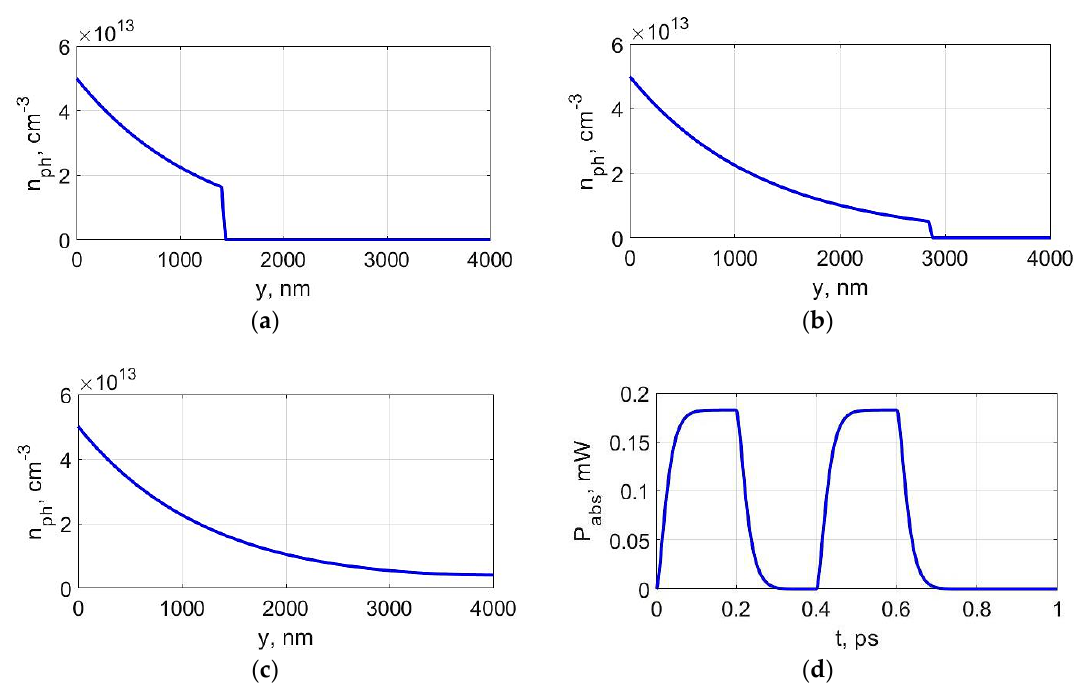
Figure 4. The spatial distributions of photon density in the resonant cavity of the p-i-n RCE 373 photodetector, as shown in Figure 1, at the instants of 0.02 ( a ), 0.04 ( b ), and 0.1 ( c ) ps; the time 374 dependence of optical power absorbed in the resonant cavity of the p-i-n photodetector ( d ). 375